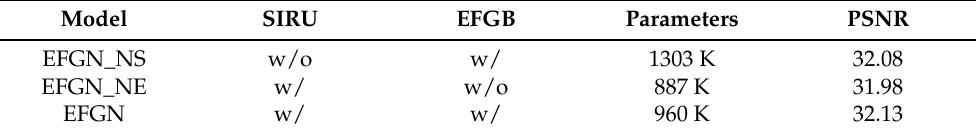
Table 3. Investigations of SIRU scheme and EFGB module for scale factor × 4 on Set5 dataset. w/ and w/o represent with and without, respectively.